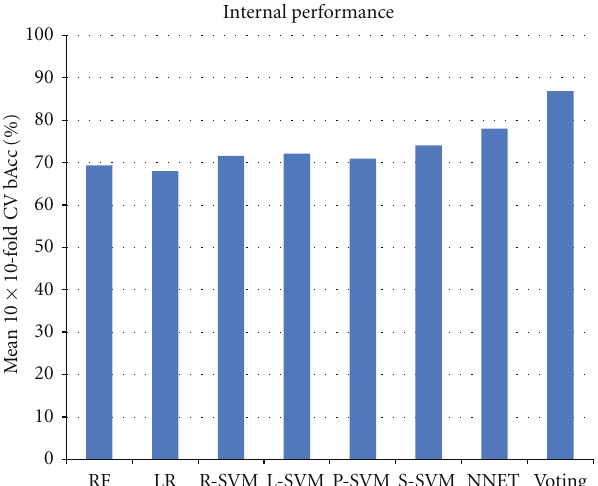
Figure 3: Internal validation performance. Shown in blue his- tograms are the mean 10-times repeated 10-fold cross-validation balanced accuracy performance (bAcc) within the two training datasets: AM and RO. Methods used are random forest (RF), logistic regression (LR), support vector machines with a radial (R-SVM), linear (L-SVM), polynomial (P-SVM), sigmoid kernel (S-SVM), a neural network with a single hidden layer (NNET), or cross-method voting (Voting).